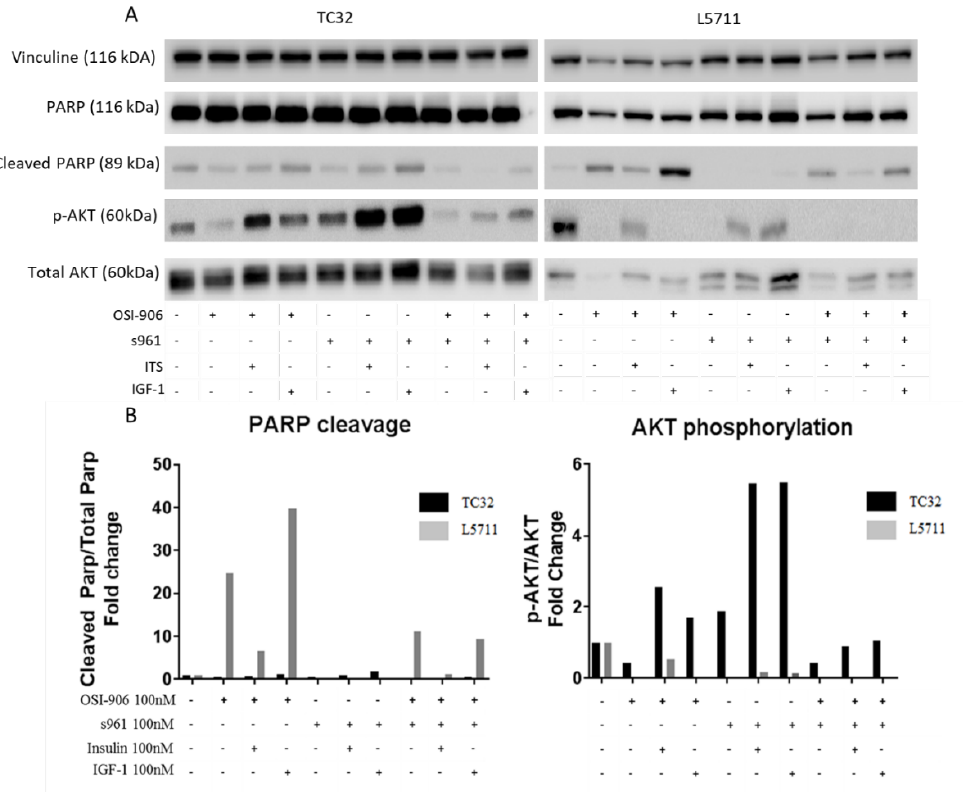
Figure A2. Induction of PARP cleavage and the reduction of AKT phosphorylation by OSI-906 saved by insulin in Ewing sarcoma cell lines ( n = 1). ( A ) Western blot with PARP; p-AKT and total AKT with s961, insulin and IGF1. ( B ) Quantification of Western blots displayed as fold changes with the untreated control set to 1. OSI-906 was overall more effective in reducing AKT phosphorylation and inducing PARP cleavage in the L5711 cell line than the TC32 cell line. This susceptibility may be explained because L5711 is a TP53, CDKN2A/B and STAG2 wild type, while TC32 has a homozygous loss of the CDKN2A/B locus. The addition of insulin reduced PARP cleavage and increased AKT phosphorylation in the presence of the IGF1R inhibitor OSI-906 in the L5711 cell line.